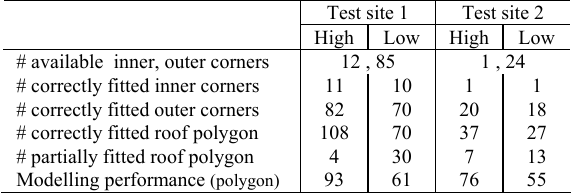
Table 3: Summary of 3D roof modelling (corners, fitted through